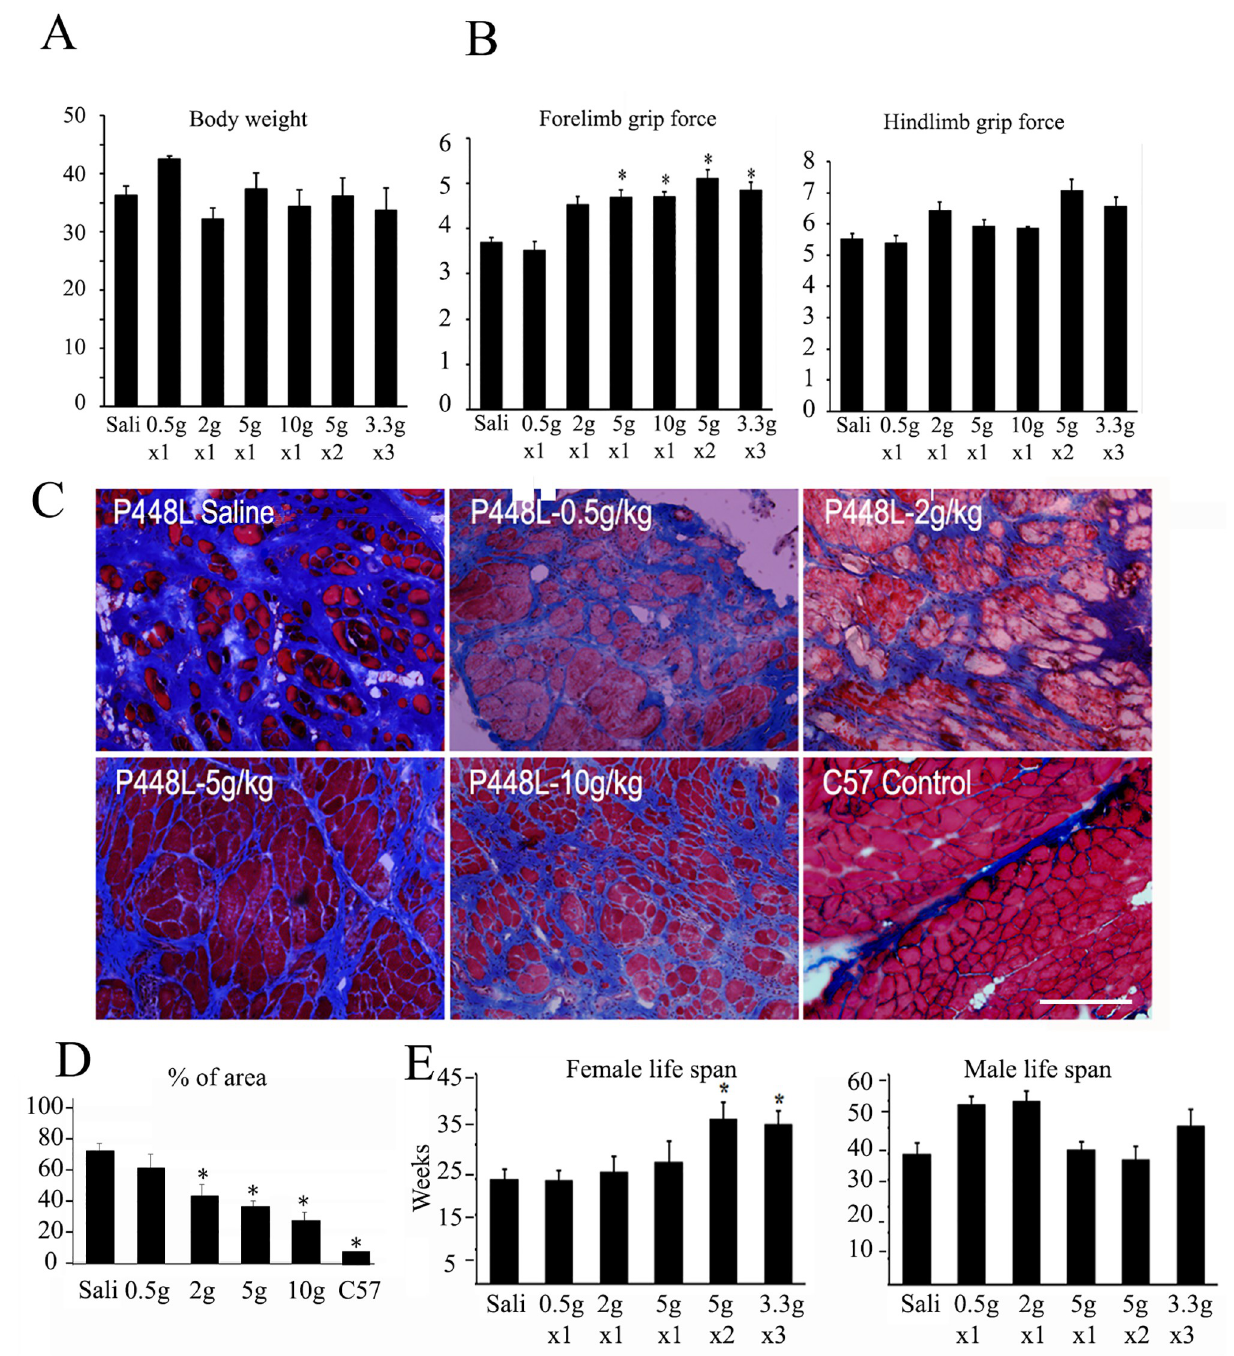
Fig 6. Effect of ribitol on body weight, muscle function, fibrosis and life span of P448L mutant mice treated with ribitol starting from 10 months of age. (A) Effect of ribitol treatment on body weight. (B) Ribitol effect on muscle function with grip force tests. (C) Masson Trichrome staining showed fibrotic area (represented by blue staining). (D) Measurement of Masson Trichrome staining of fibrotic areas. % of total area with blue staining. (E) Effect of ribitol treatment on life span of female and male mice. � , P < 0 . 5 n = 20 for A, B; n = 5 for D; n = 10 for E. Sali, saline treatment as control. The number of weeks is calculated starting from the treatment at 10 months of